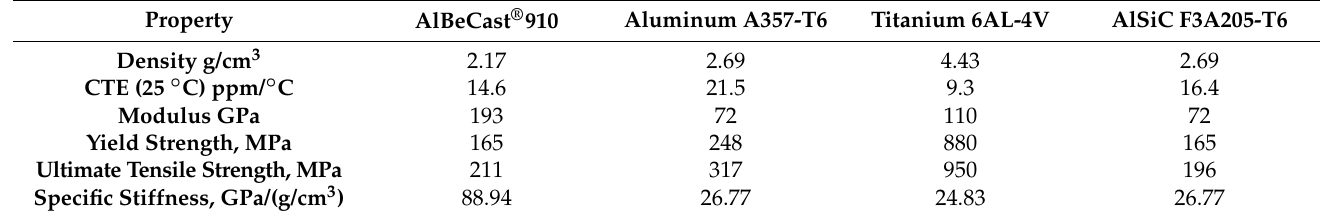
Table 1. The properties of Be-Al alloy and other light alloys